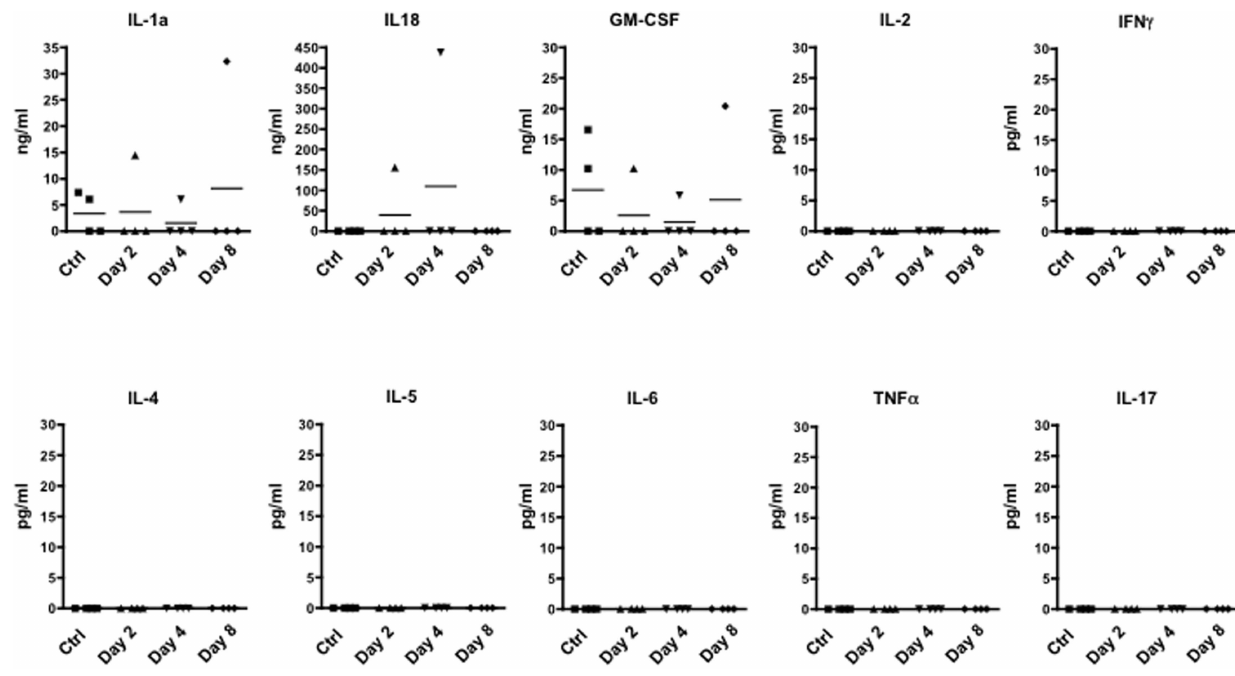
FIGURE 4 | Levels of inflammatory cytokine in the plasma of MOG 35–55 -immunized mice .The graphs show the level of the indicated cytokines in the plasma of control or MOG 35–55 -immunized mice sacrificed at the indicated time points.The results are representative of n = 4